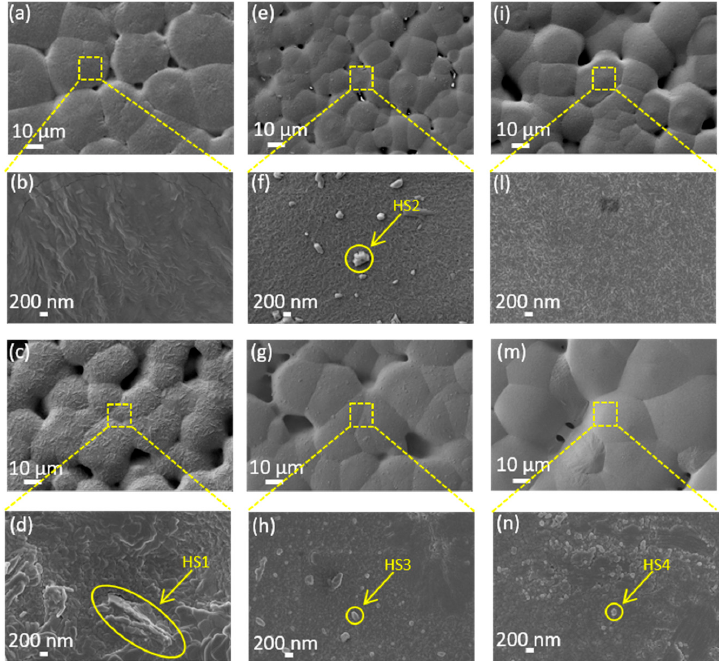
Figure 3. FE-SEM low-magnification and high-magnification micrographs of ( a , b ) Neat-PVDF, ( c , d ) M1-HS1 film, ( e , f ) M1-HS2 film, ( g , h ) M1-HS3 film, ( i , l ) M1-HS4 film, and ( m , n ) M1-HS5 film.